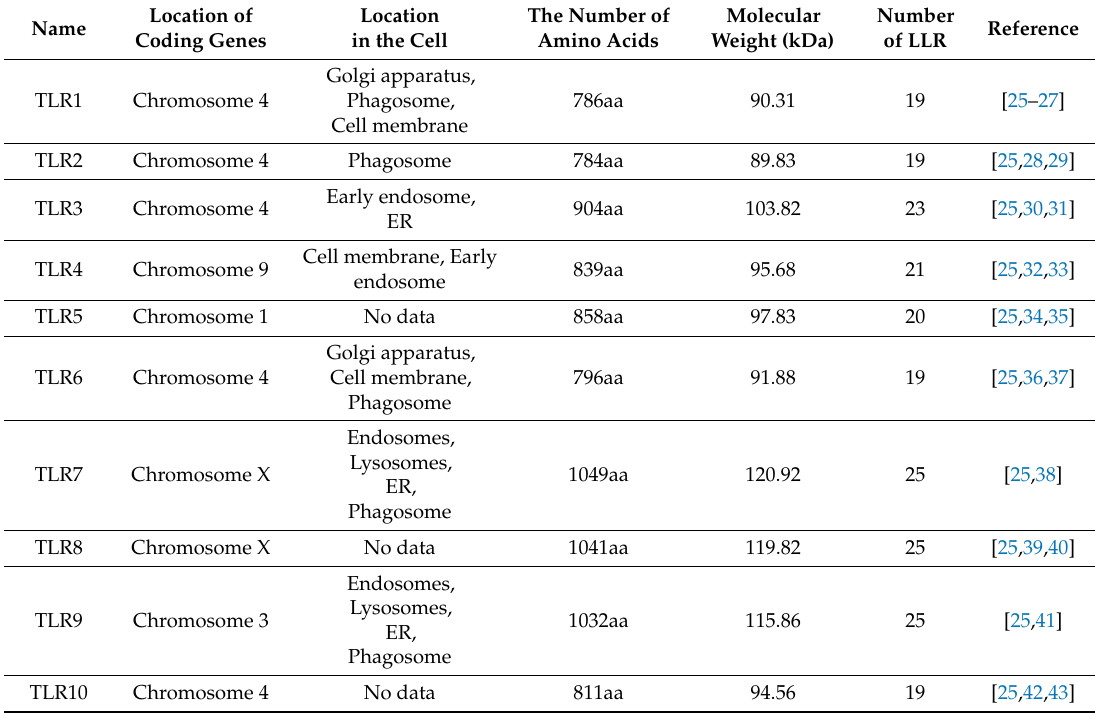
Table 1. Characteristics of individual TLRs (toll-like